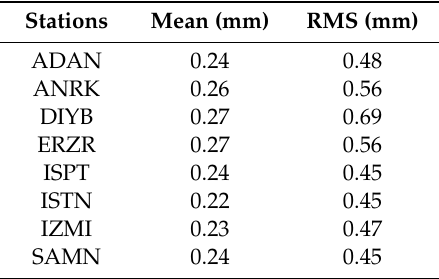
Table 1. Mean and root mean square (RMS) values of the zenith tropospheric delay (ZTD) di ff erences on days 167–180 in 2011.